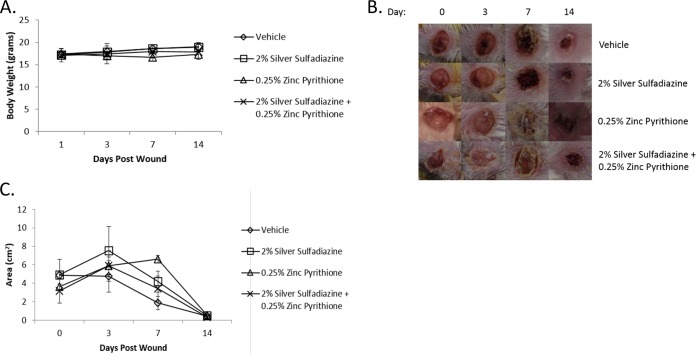
Effects of PEG-based ointments on wound healing and animal health. Panel A shows the average (n = 3) body weights of animals (y axis) at the indicated days (x axis) of treatment with the PEG-based ointments containing the indicated agent or mixture. Panel B shows representative wound healing images following days 0, 3, 7, and 14 of treatment with PEG-based ointments containing 2% silver sulfadiazine or 0.25% zinc pyrithione or their combination. Panel C shows average (n = 3) wound contraction corresponding to the images in panel B.